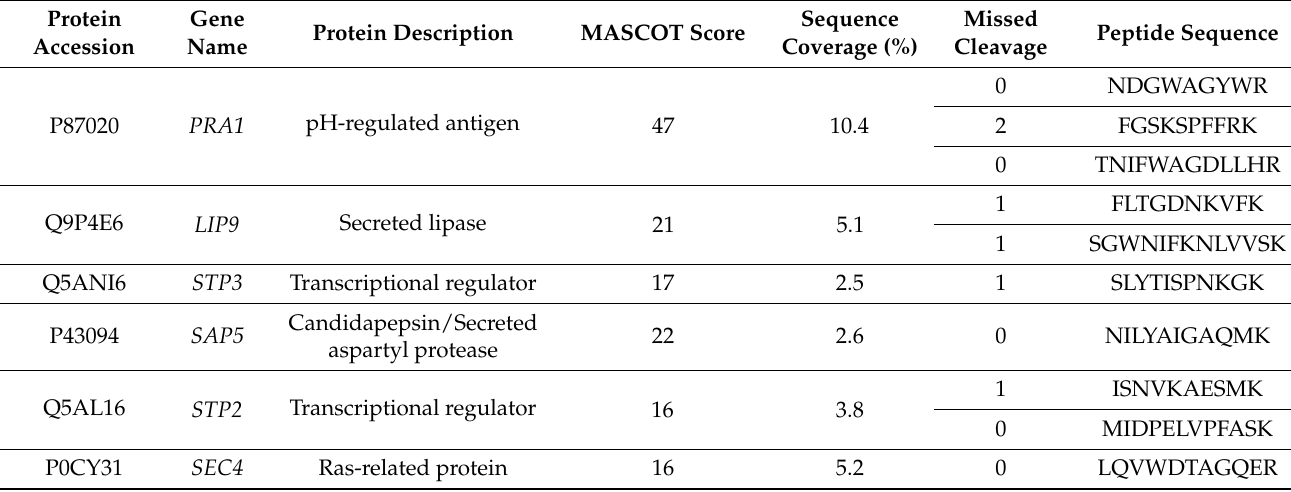
Table 6. Proteins involved in virulence were identified in the fluconazole-resistant C. albicans strain. All proteins were identified using MASCOT.